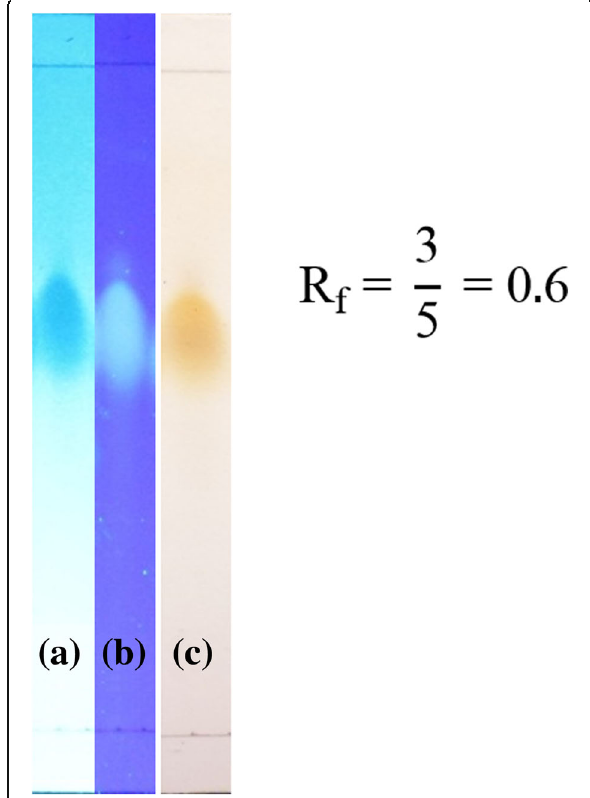
Fig. 1 TLC chromatogram of fraction 3-(7 – 9)-(7&8) using an ODS plate with 100% methanol under UV light at λ 254 nm ( a ); UV light at λ 365 nm ( b ); and after spraying with 10% H 2 SO 4 in methanol to make the colour persist ( c